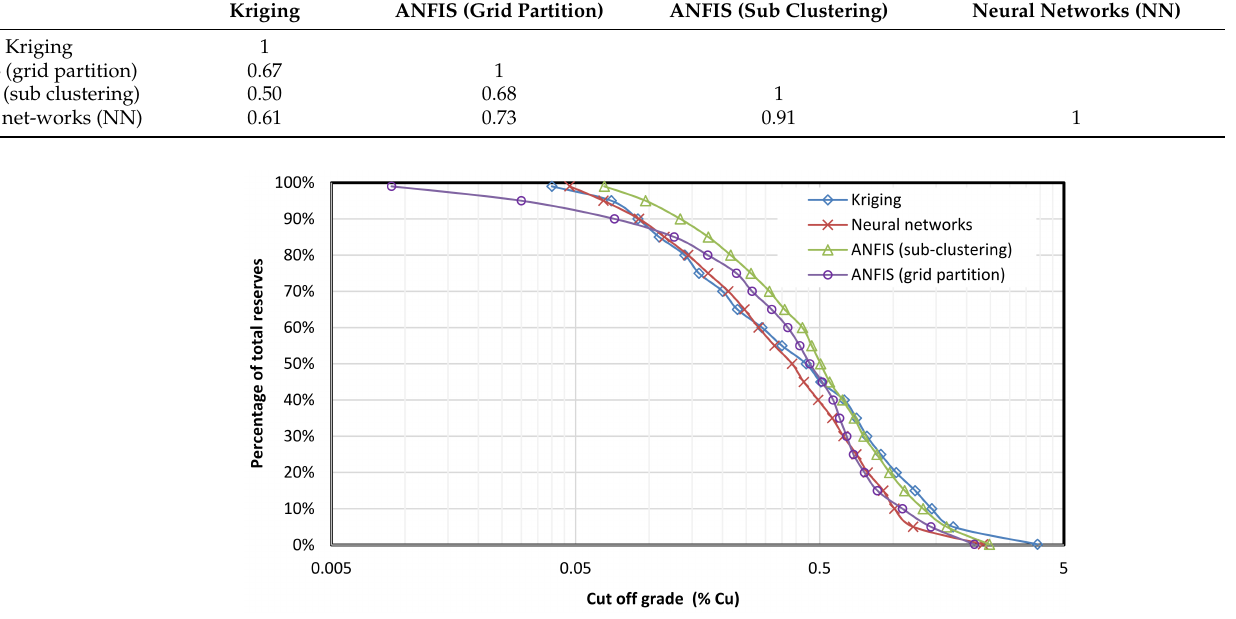
Figure 3. Grade–reserves curves for the different applied estimation